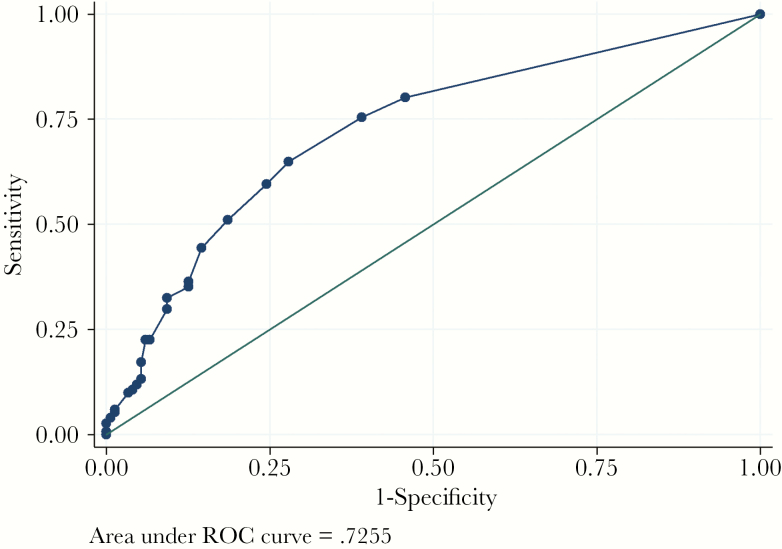
ROC, receiver operating curve.